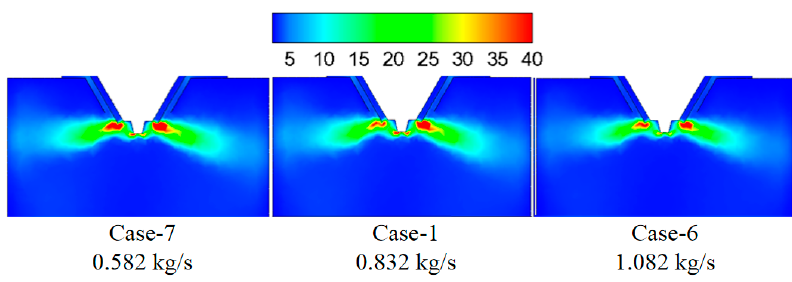
Figure 10. Turbulence kinetic energy under different waste water flow rates (m 2 /s 2 ).